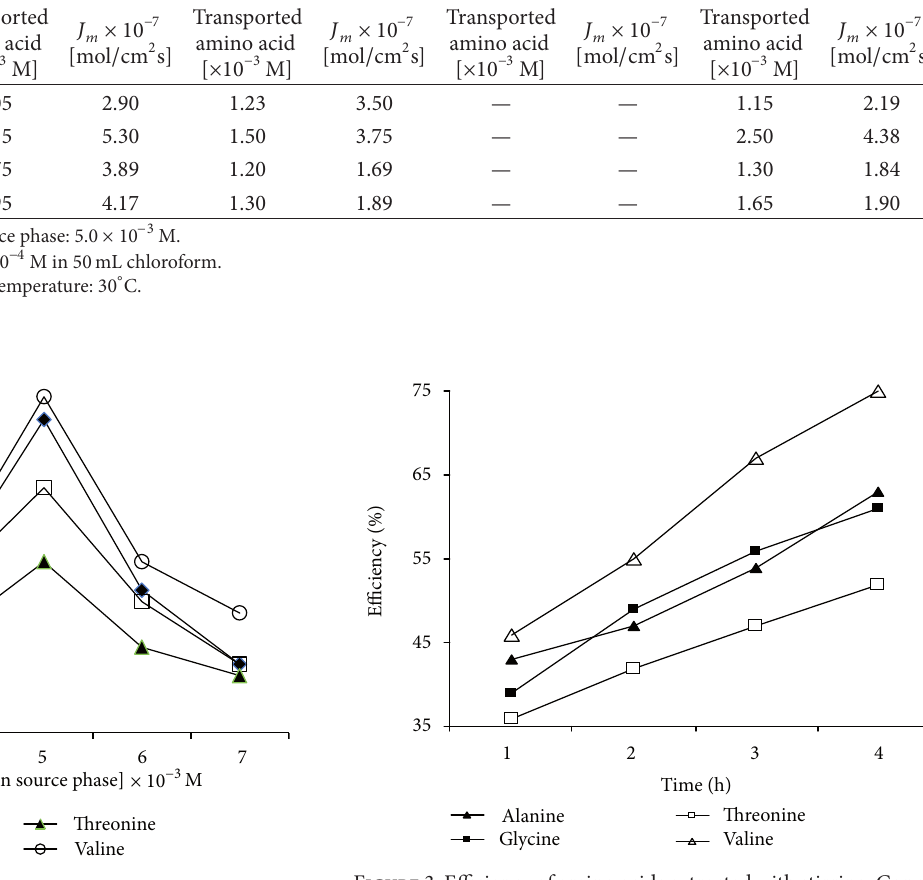
F 3: Efficiency of amino acids extracted with stirring. Concen- tration of amino acid in source phase